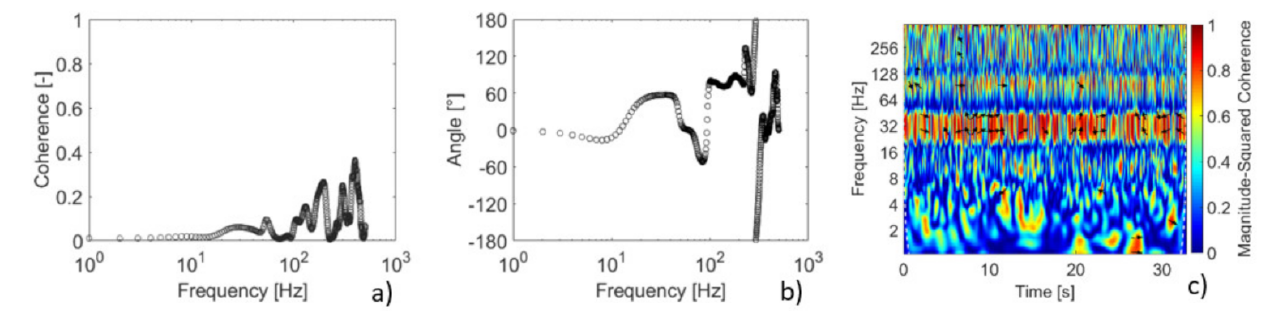
Figure 13. ( a ) Cross-coherence of the acceleration signals from both cylinders free to vibrate for reduced velocity equal to Vr = 18 for the first cylinder and Vr = 52 for the second cylinder, ( b ) phase angle obtained in the cross-coherence, and ( c ) wavelet coherence of the acceleration from the first cylinder and acceleration from the second cylinders free to vibrate for equal reduced